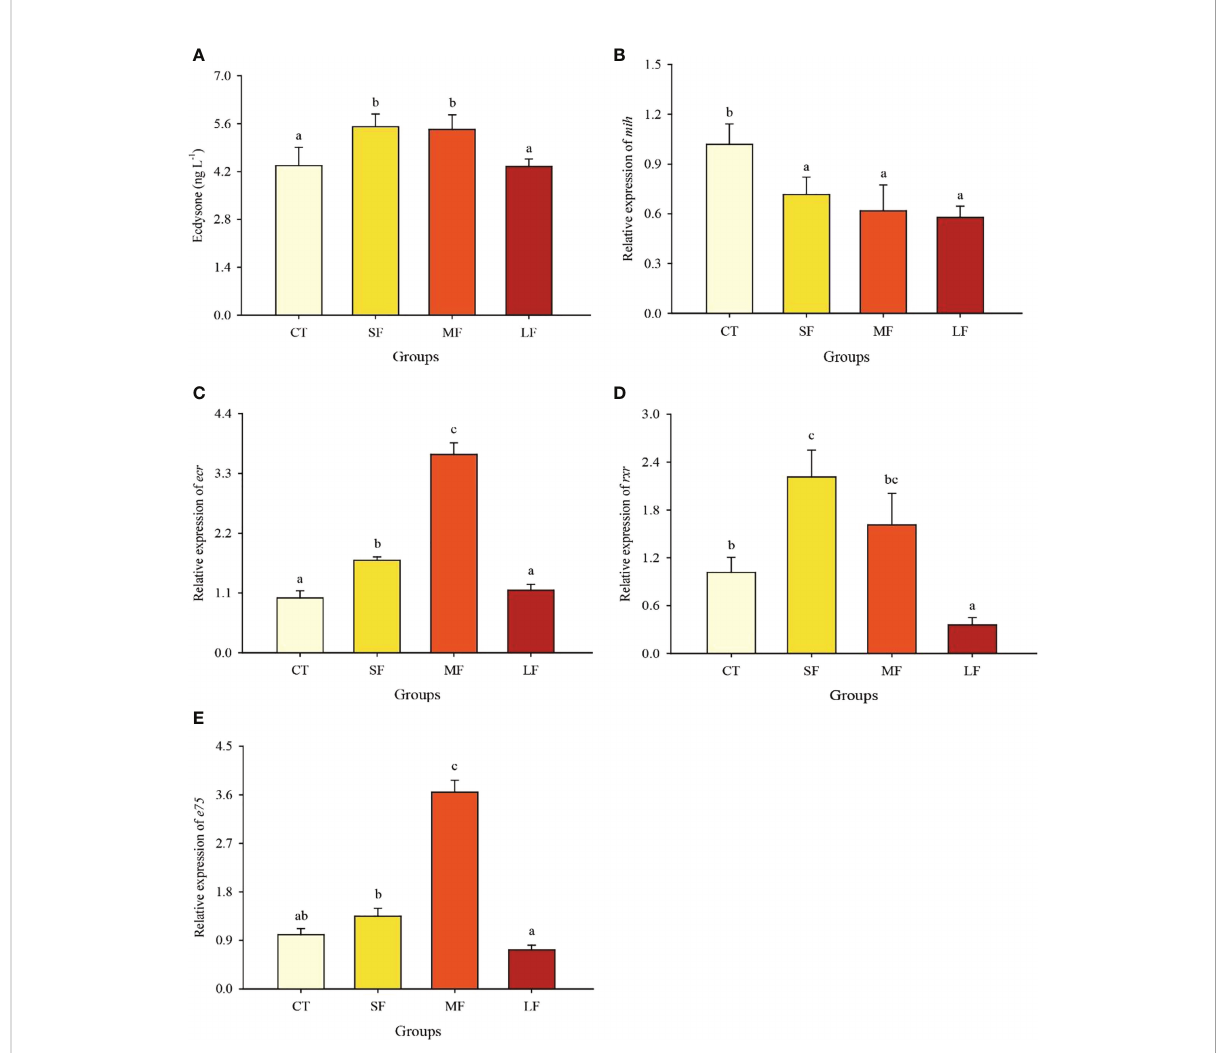
FIGURE 2 Ecdysone levels in haemolymph (A) . Relative expression of mih (B) , ecr (C) , rxr (D) and e75 (E) gene of the eyestalk. Values are expressed as mean ± SD (n=3). Different superscripts indicate signi fi cant differences between treatments ( P <